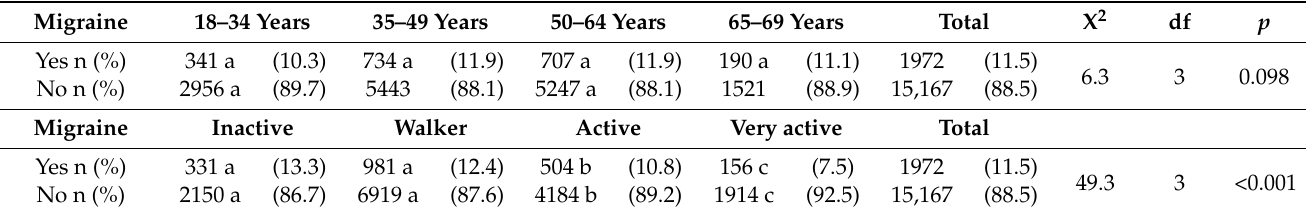
Figure 1. Prevalence of migraine, according to age and physical activity level. Table 2. Prevalence of migraine by age group and level of physical activity. Contrast of proportions and dependency analysis between groups and migraine